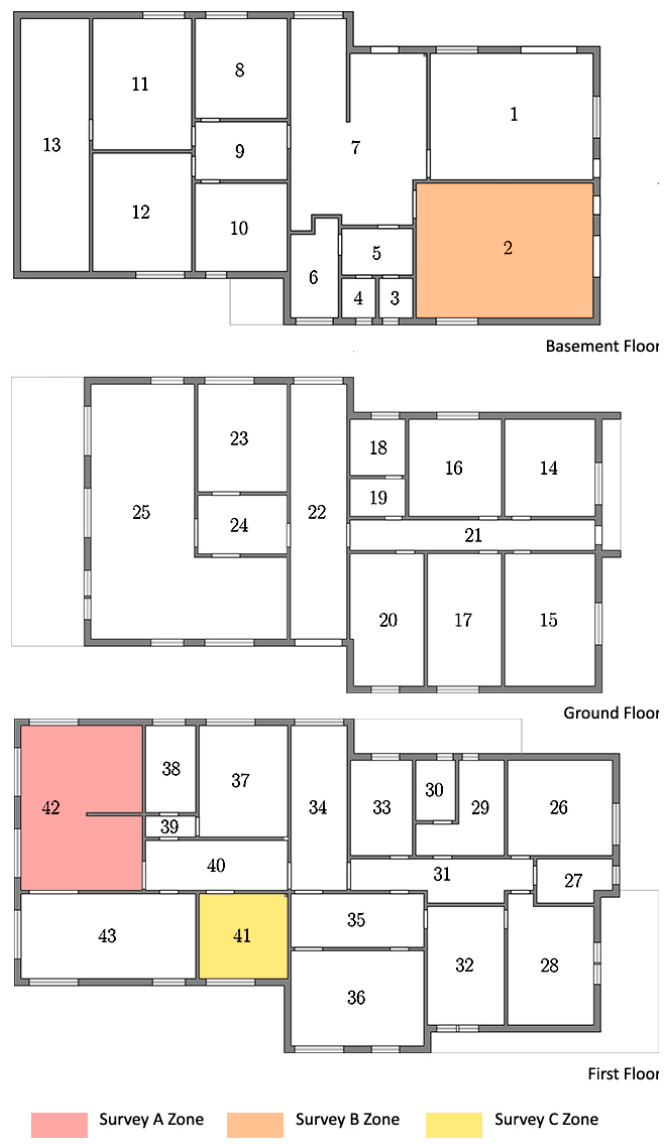
Figure 5. First guess model in IDA-ICE’s 3D environment.